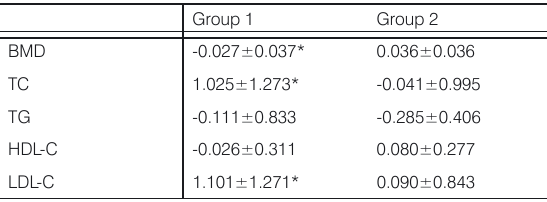
Table 4. Differences in BMD and lipid parameters between the groups, after the examination period.